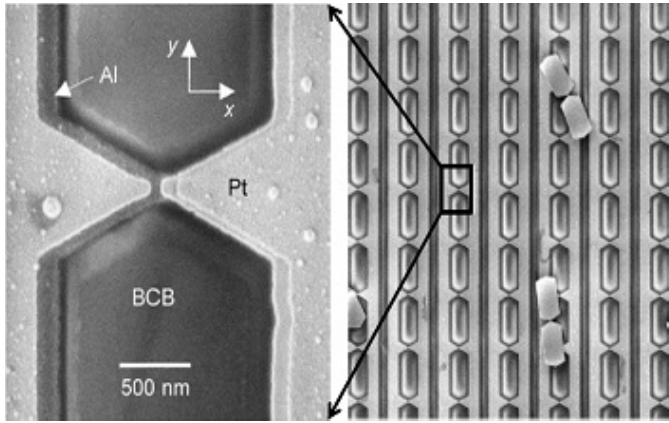
Figure 12. Frequency selective surface using slot antenna coupled to MOM diode